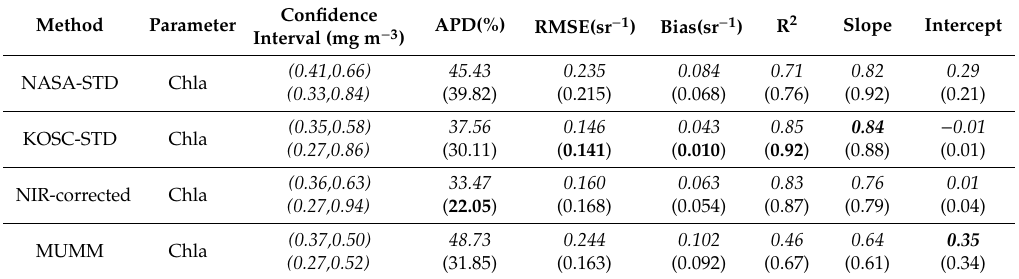
Table 10. Statistical results for the retrieved values of chlorophyll-a (Chla) obtained using NASA-STD, KOSC-STD, Kd-based, and MUMM algorithms and in situ Rrs comparison at 02:16, 03:16, and 04:16 UTC. The italic numerals of each index represent ± 3 h, while the statistical results in parentheses are ± 1 h.